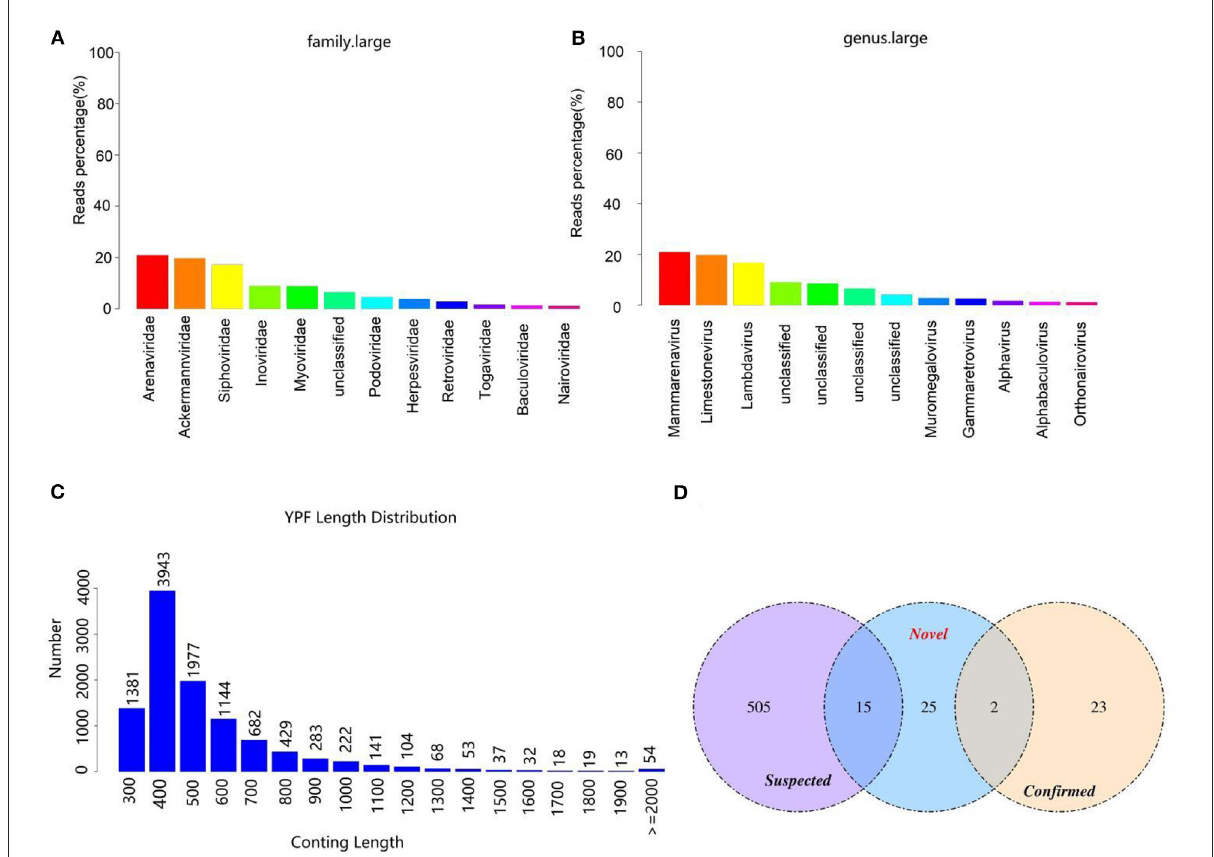
FIGURE1 Viral composition and the length distribution of contigs. (A) The relative abundance of viral composition at the level of family. (B) The relative abundance of viral composition at the level of genus. (C) The length distribution of contigs. The abscissa represents the length of contigs and the ordinate indicates the number of contigs. (D) Comparison of the number of viruses contigs obtained by different methods.